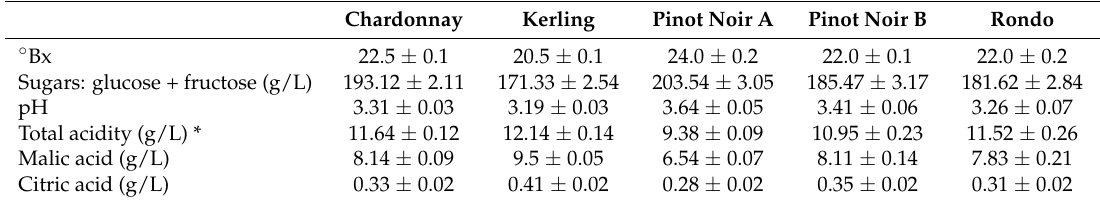
Table 5. Characteristic of grape must used for the vinification process [13]. Chardonnay Kerling Pinot Noir A Pinot Noir